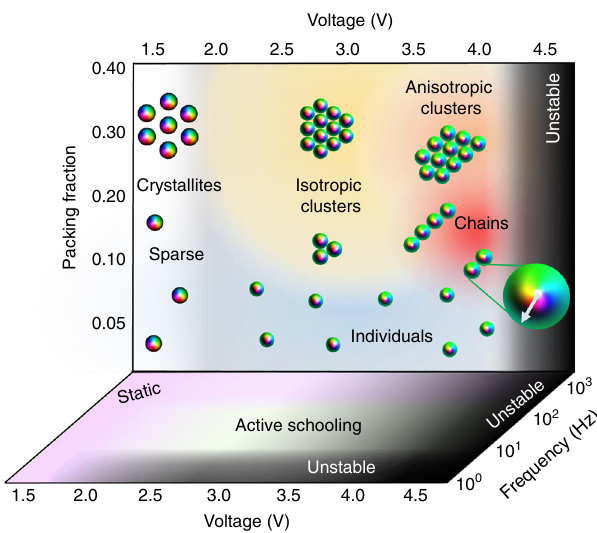
Fig. 7 Diagram of static and dynamic skyrmion assemblies and schools. A diagram of experimentally self-assembled dynamic and static structures versus packing fraction, f and U . The con fi gurations shown are consistent across all f at which skyrmions are stable and shown as a single vertical panel for simplicity. Schematics of skyrmion assemblies in the insets are colored according to the scheme in the inset of Fig. 1g, with the enlarged inset displaying the preimage vector of a skyrmion at U = 4.0